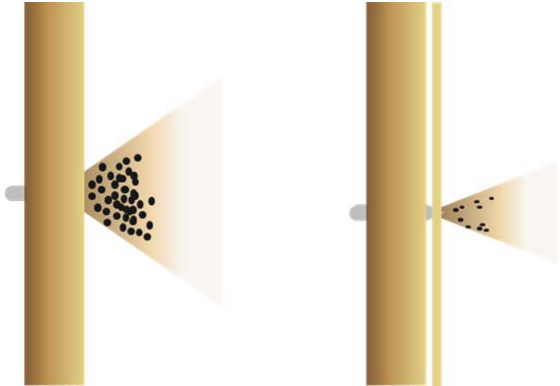
Figure 2. A spall liner is used on a light armored vehicle [7].